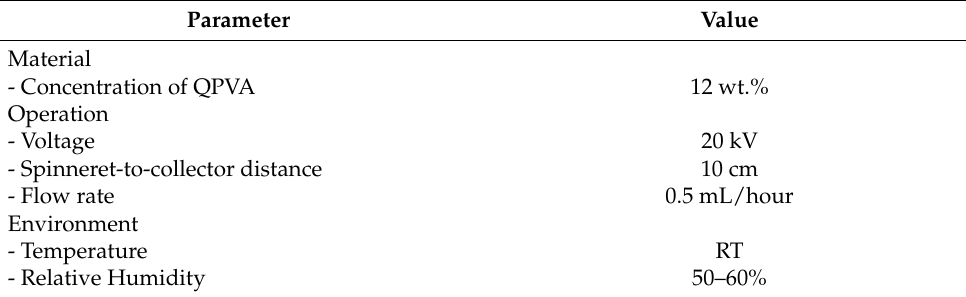
Table 2. Parameter process of electrospinning.